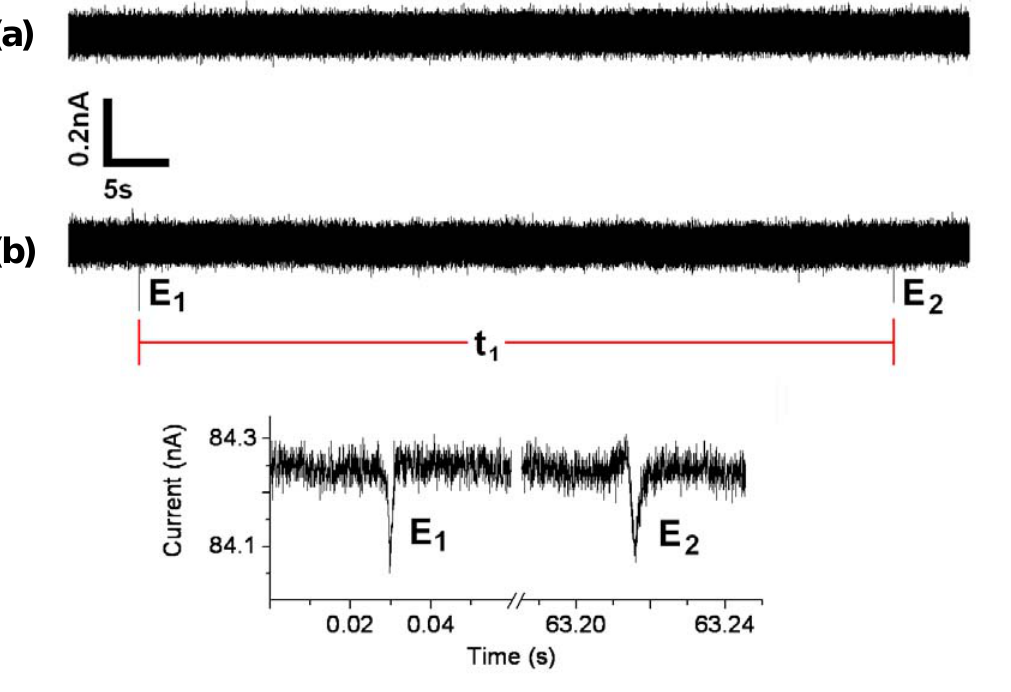
Figure 6. (a) Open conductance of a 10 µm pore at 700 mV applied potential. (b) Yeast translocation events using a 2  10 2 yeasts/ml sample, caused by multiple